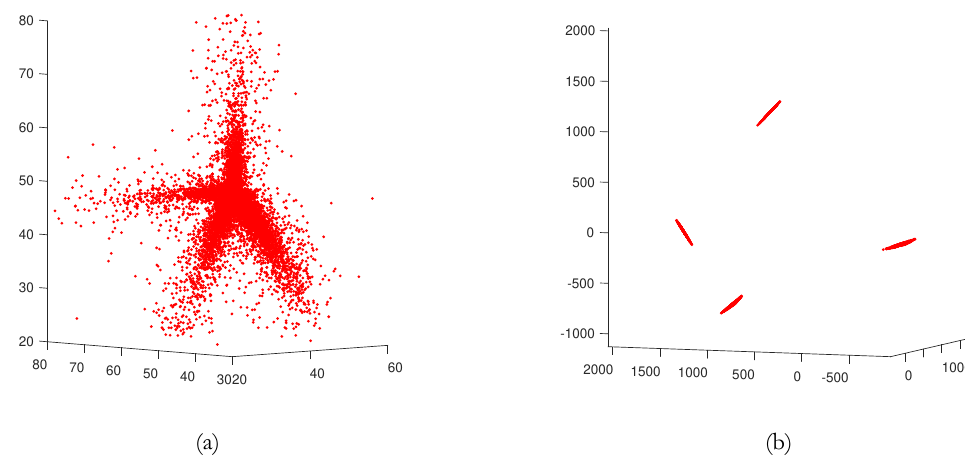
Fig. 3:Four-spoke radial data set with random spokes and outliers